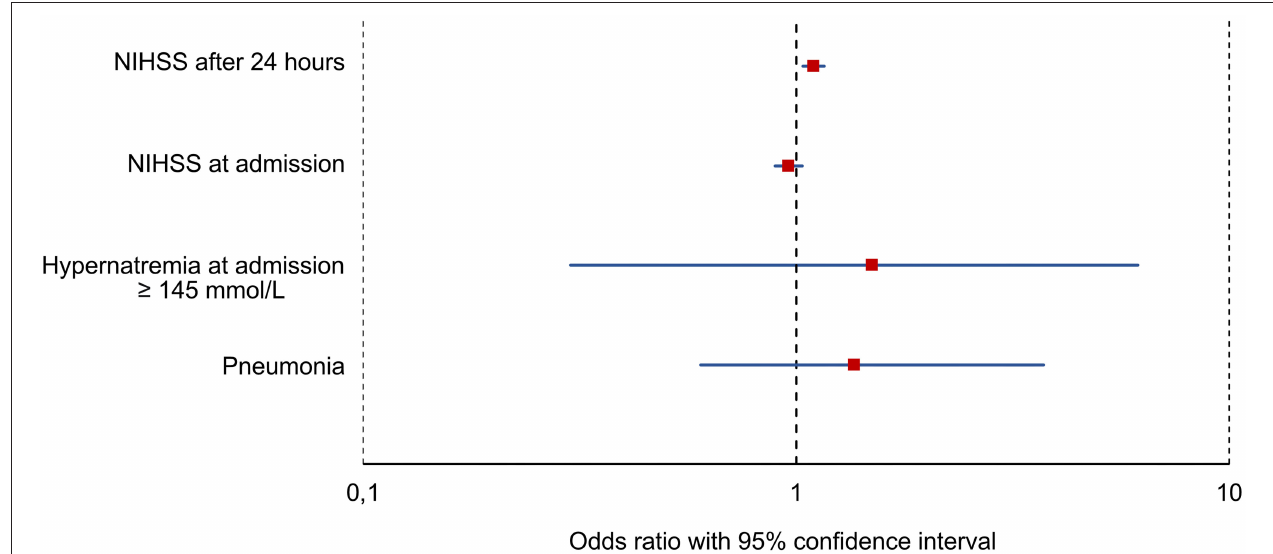
FIGURE 1 | Results of the multiple regression analysis. Red squares represent the odds ratio and blue horizontal bars represent the 95% confidence interval. NIHSS, National Institutes of Health Stroke Scale.